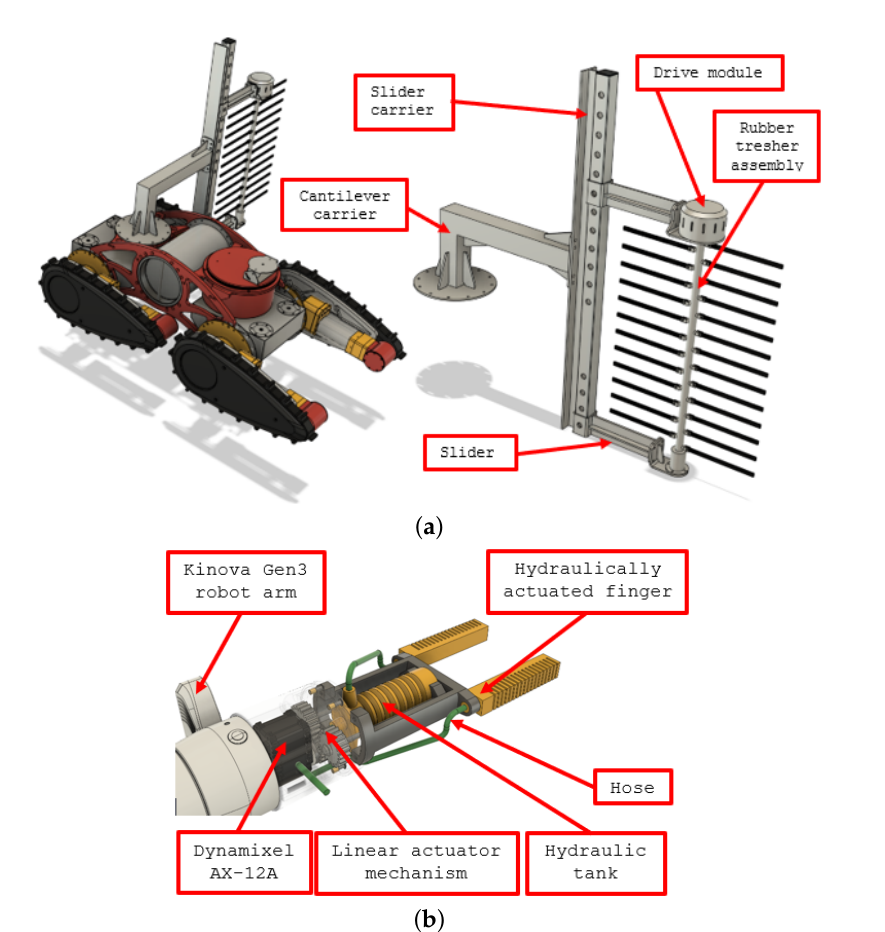
Figure 4. Suckering specialized tools: ( a ) standalone rubber threshing system, ( b ) compliant hydrauli- cally actuated